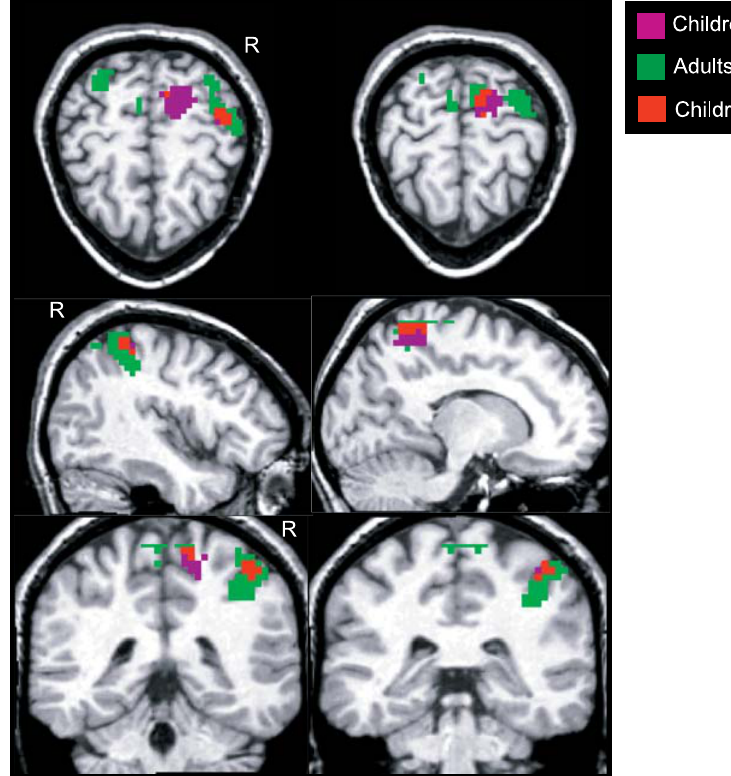
Figure 5. Child and Adult Number-Selective Brain Regions (Number . shape from Figures 2 and 3) plotted in same space. Adults showed more extensive areas of activation than children; however, the same brain regions were active for children as for adults in this